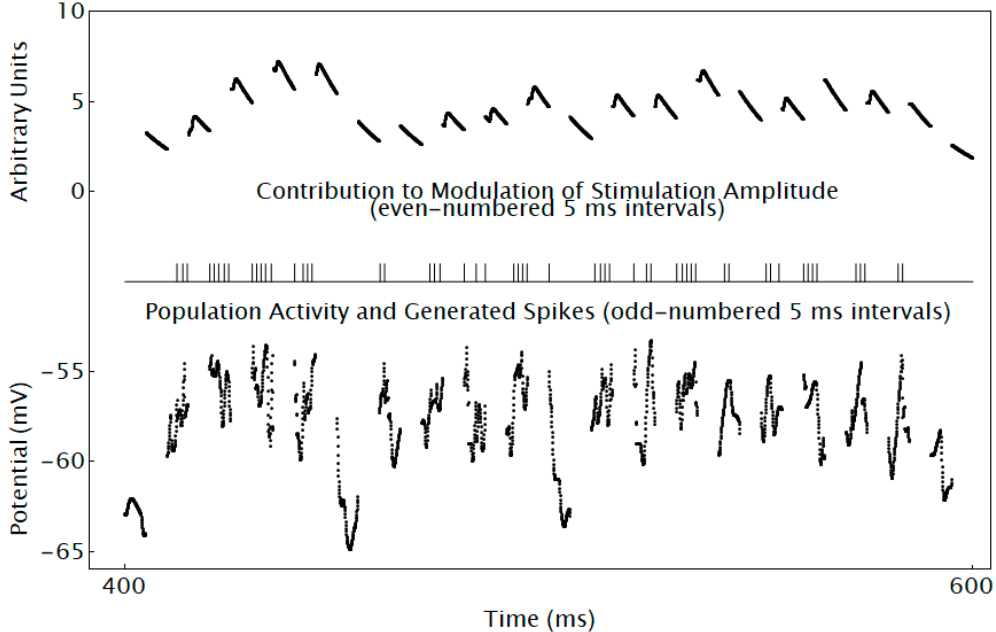
Figure 10. Simulated activity of column 1 neurons and simulated spikes resulting from values greater than −57 mV are shown during odd-numbered 5 ms intervals, and the membrane potential of a model neuron that is influenced by these spikes via G system synapses is shown during even-numbered 5 ms intervals. Data are displayed for 200 ms in order to provide a clear visualization of the data for each interval and the impact of spikes on the contribution of column 1 activity to modulation of intermittent stimulation of column 1 neurons.